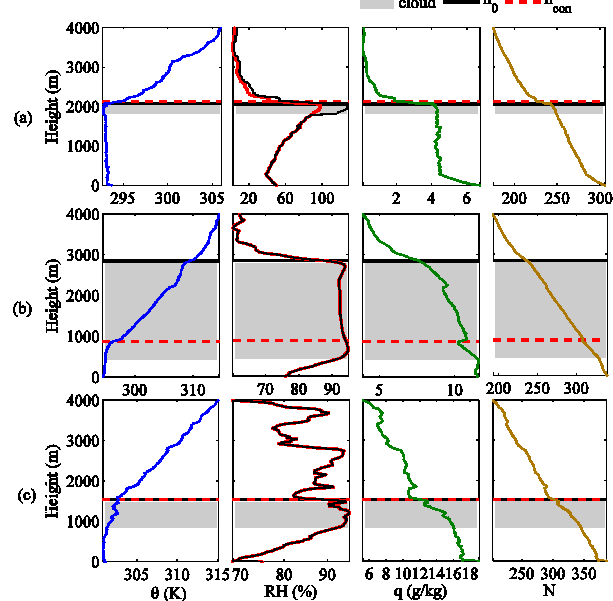
Figure 3. The profiles of potential temperature ( θ) , relative humidity (RH) (the red profile is the RH with respect to the liquid water and the black profile indicates the RH with respect to ice when the temperature is below 0 ◦ C), specific humidity ( q) , refractivity ( N) and the mixing layer heights. The y axis is the height above ground level. Cloud derived from the RH with respect to ice is located in the shadow region. (a) Station #03948 (35.2 ◦ N, 97.4 ◦ W) at 00:00UTC (17:30LST) on 22 May 2001; (b) station #14898 (44.5 ◦ N, 88.1 ◦ W) at 00:00UTC (18:06LST) on 25 August 2006;